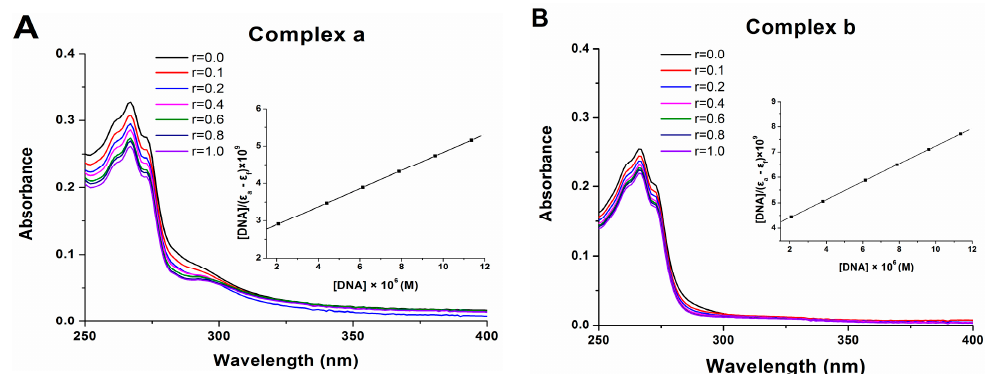
Figure 7. UV-Vis spectra of complex a ( A ) and b ( B ) upon addition of CT-DNA with the concentration ratio (r) of platinum complex to DNA of 0, 0.1, 0.2, 0.4, 0.6, 0.8 and 1.0, respectively (the insert is the plot of [DNA]/( ε a − ε f ) vs. [DNA]).